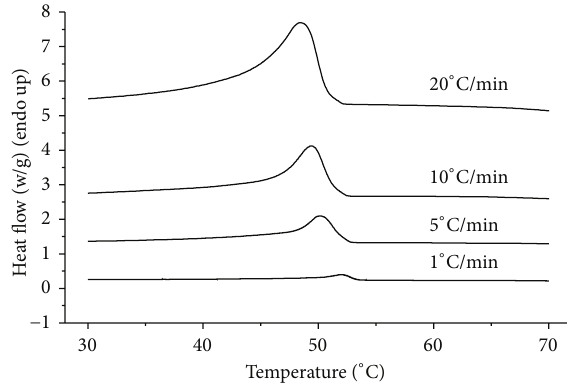
Figure 2: Nonisothermal melt crystallization exotherms for MAG organogels at four different cooling rates (1, 5, 10, and 20 ∘ C/min,